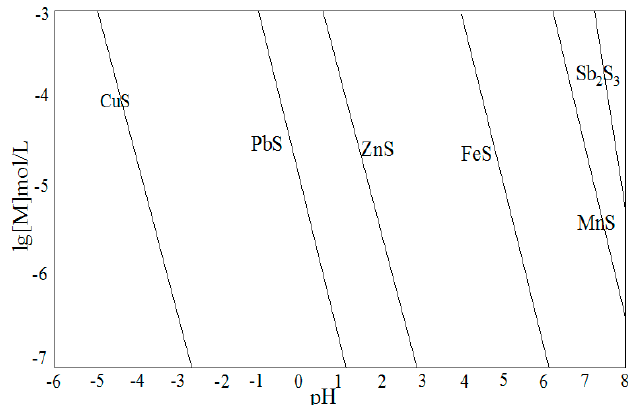
Figure 7. Relationship between the residual concentration of metal ions and pH.